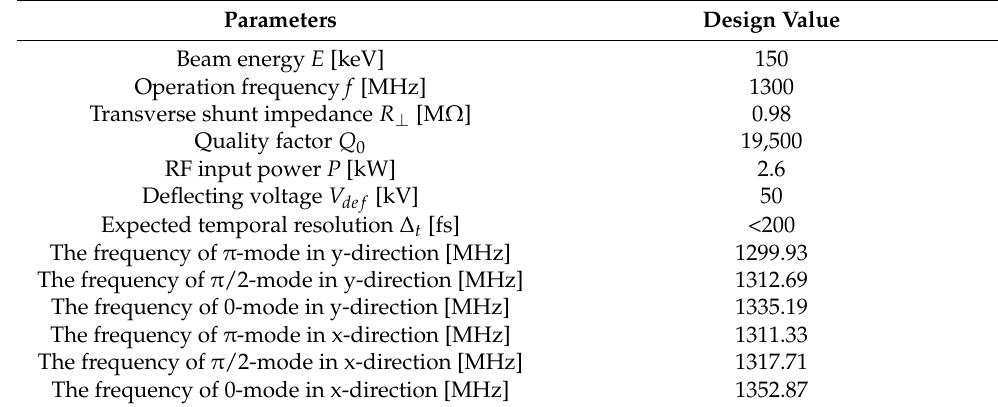
Table 2. Design parameters of the deflecting cavity.